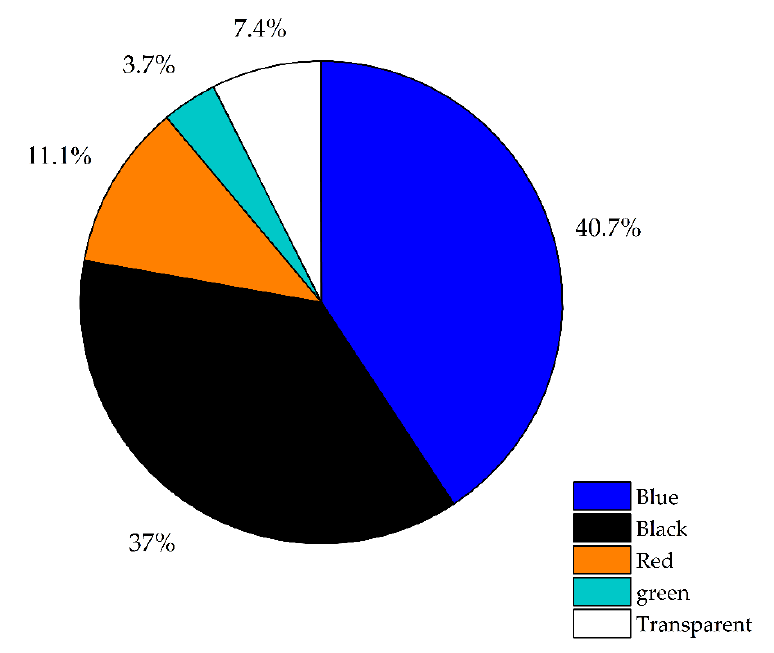
Figure 8 . The relative proportions of various microfiber colors and the amounts present in fish eggs .